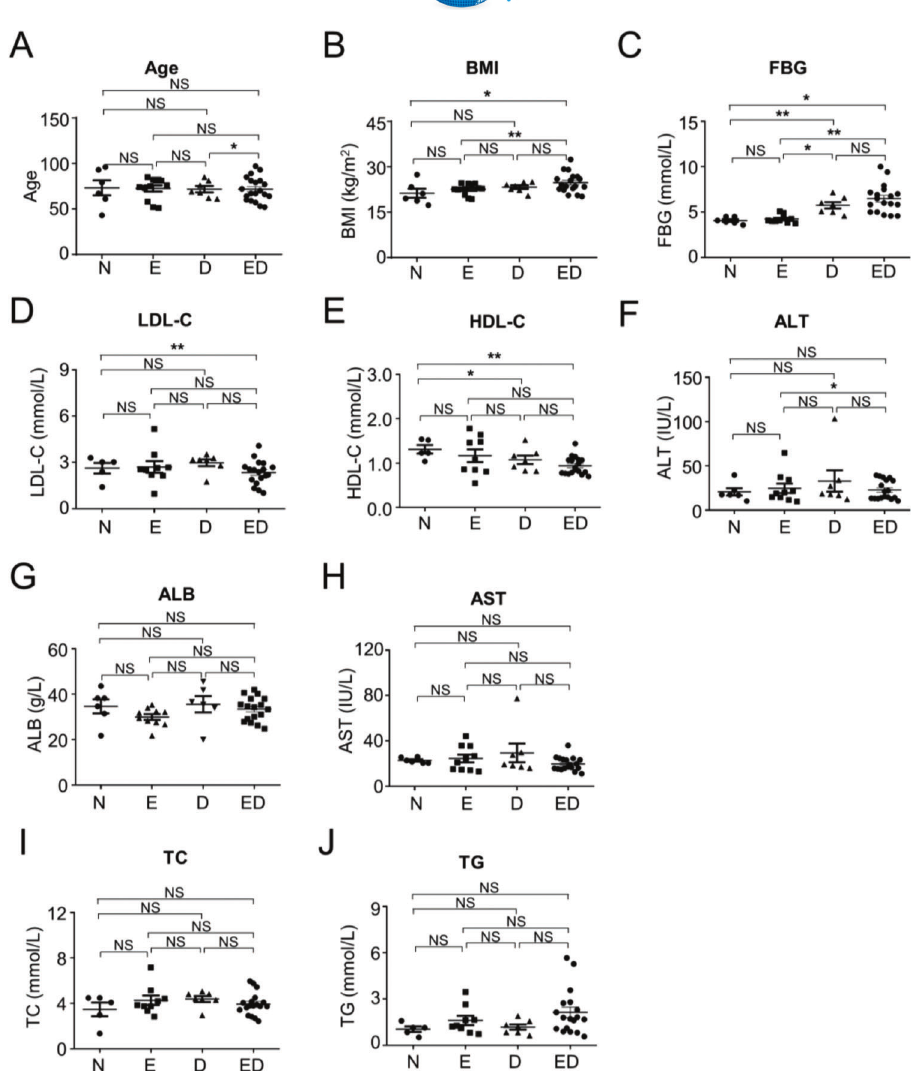
Figure 1 - Clinicopathological parameters involved in E, D, ED, and N groups. ( A ) The comparation of age distribution among E (essential hypertension), D (type 2 diabetes mellitus), ED (patients with essential hypertension and concomitant type 2 diabetes mellitus), and N (healthy donors) groups. ( B-J ) Comparations of clinicopathological parameters among N, E, D, and ED groups, including BMI ( B ), FBG ( C ), LDL-C ( D ), HDL-C ( E ), ALT ( F ), ALB ( G ), AST ( H ), TC ( I ), and TG ( J ). All data are shown as Mean ± SEM. *, p o 0.05; **, p o 0.01; NS, not